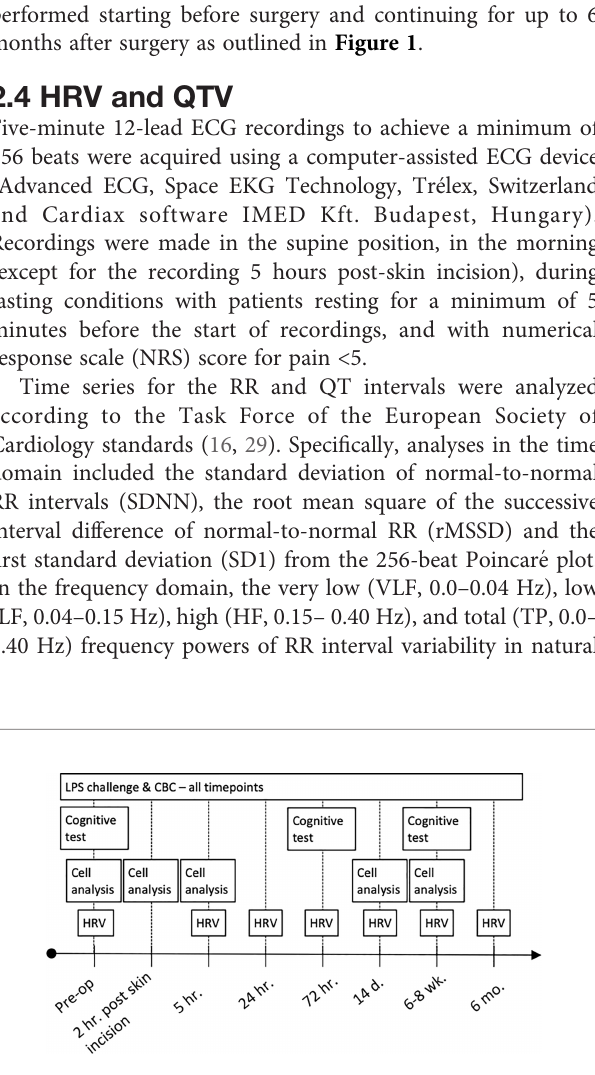
FIGURE 1 | Clinical trial pro fi le. CBC, complete blood count; LPS, lipopolysaccharide.